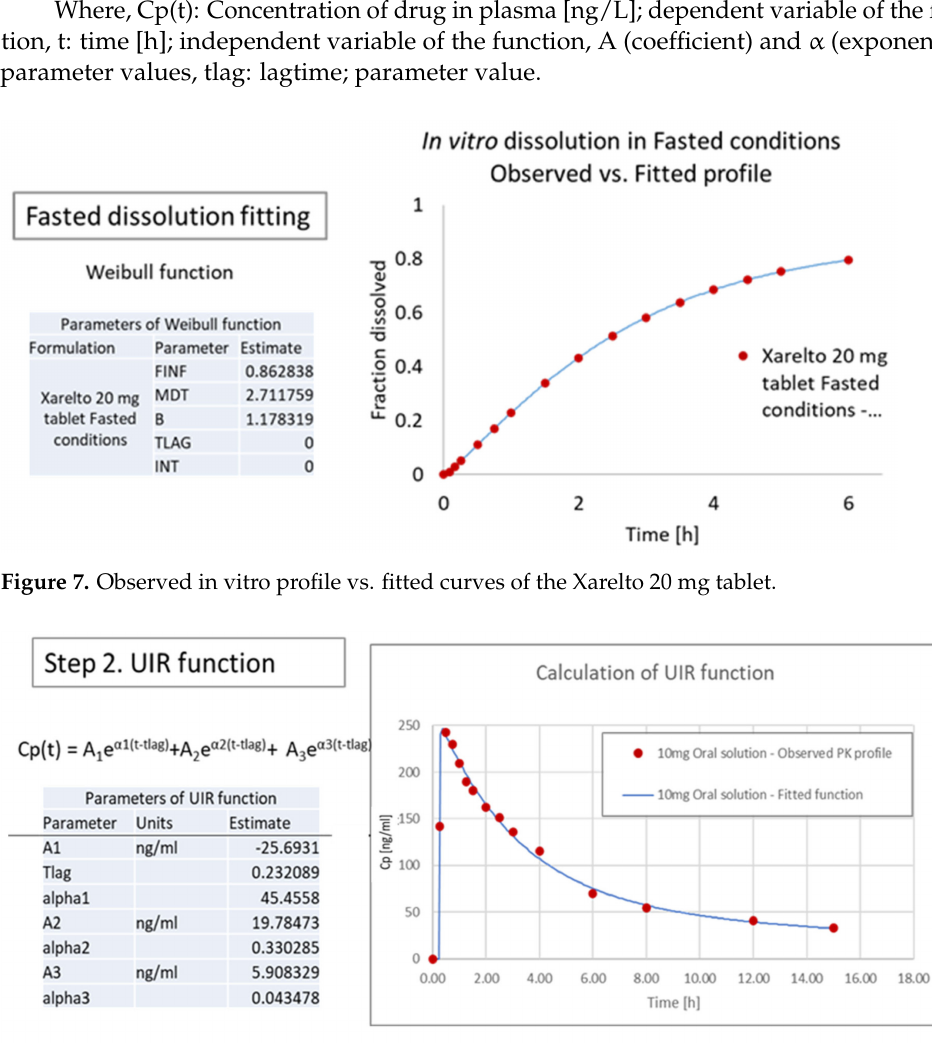
Figure 8. Properties of the unit impulse response (UIR)